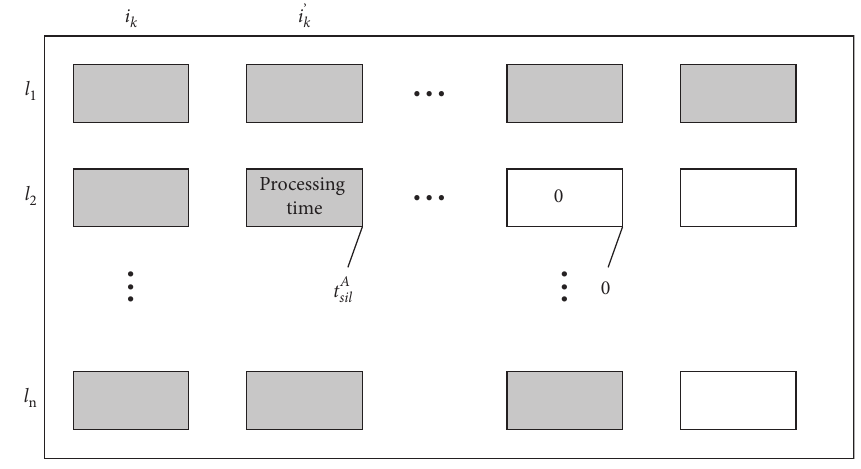
Figure 5: The encoding style and solution expression.